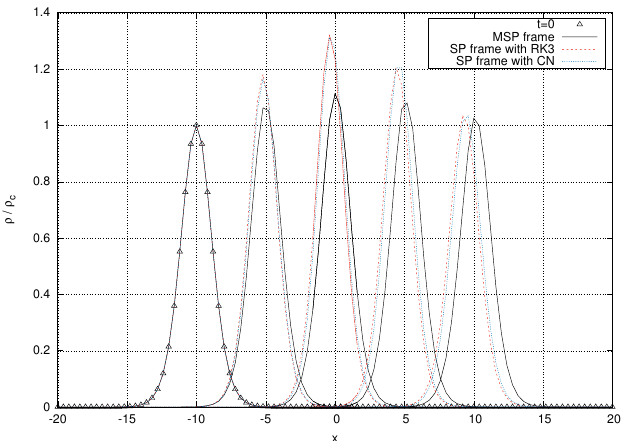
Figure 4. Snapshots of the density profile every t = 5 time units in the Madelung frame (solid line) and the SP frame (dotted lines).